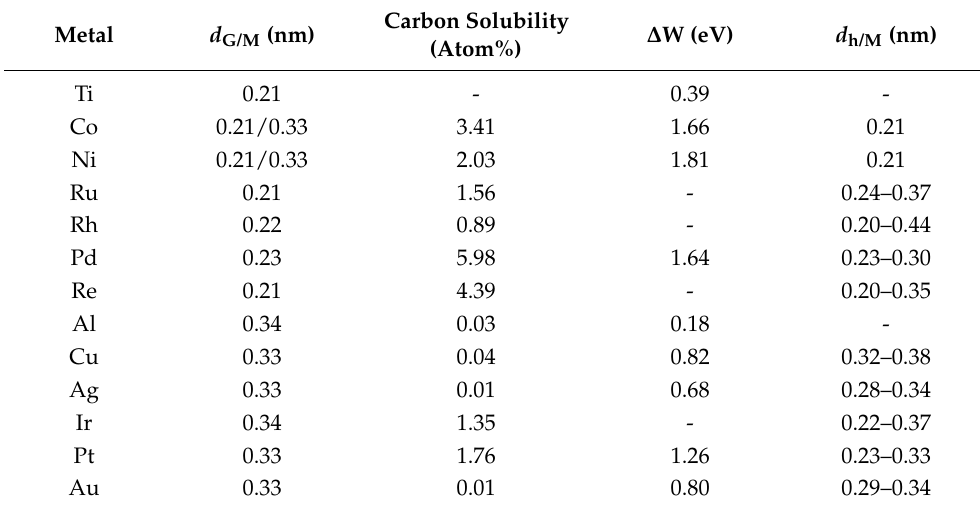
Table 2. The results calculated by DFT [13,97–104,106–117,119,121,122] for equilibrium distances of many Gr–metal interfaces ( d G/M ), carbon solubilities (in at.%) in different transition metals at 1000 ◦ C, work-function differences between clean metal surfaces and pre-adsorbed Gr ( ∆ W = W M − W G ), and equilibrium distances of the h-BN–metal interfaces ( d h − BN/M